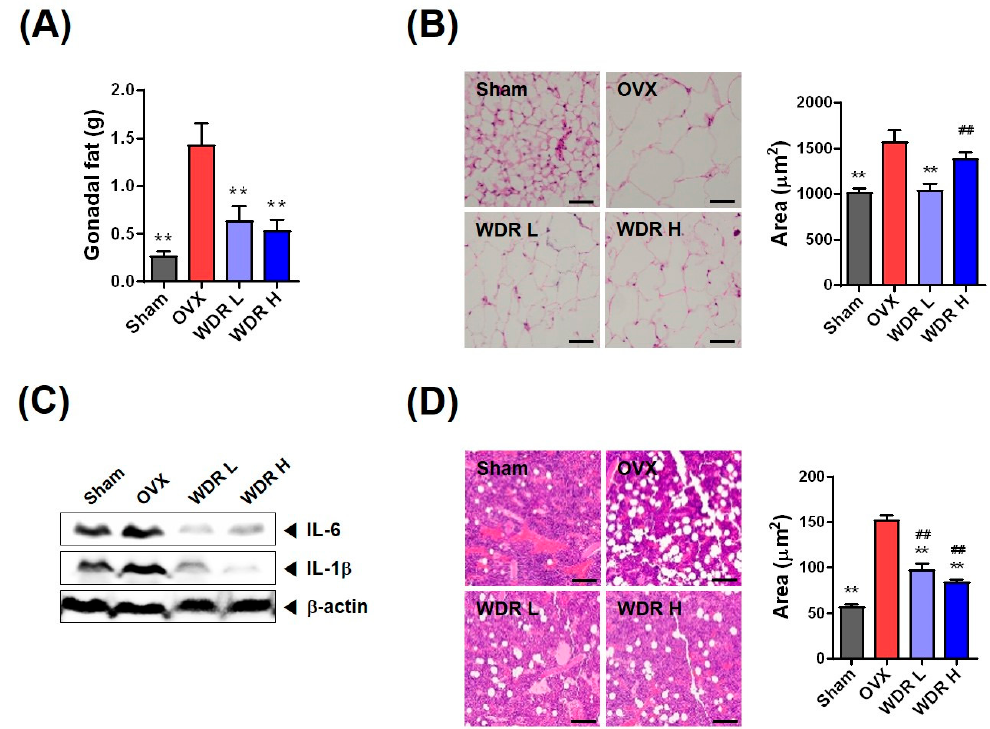
Figure 3. Effects of WDR on fat accumulation in HFD-fed OVX mice. ( A ) Change in gonadal fat weight. ( B ) Hematoxylin and eosin staining of gonadal fat tissue and the mean adipocyte size (×100). ( C ) Protein expression of IL-6 and IL-1 β in gonadal fat. ( D ) Hematoxylin and eosin staining of the distal femur and the mean lipid droplets size (×100). Sham, sham mice fed HFD; OVX, OVX mice fed HFD; WDR L, OVX mice fed HFD and WDR 200 mg/kg/day; WDR H, OVX mice fed HFD and WDR 500 mg/kg/day. The results are presented as mean ± SEM and analyzed using a one-way analysis of variance and Dunnett's post hoc test. ** p < 0.01 versus the OVX group, ## p < 0.01 versus the Sham group.